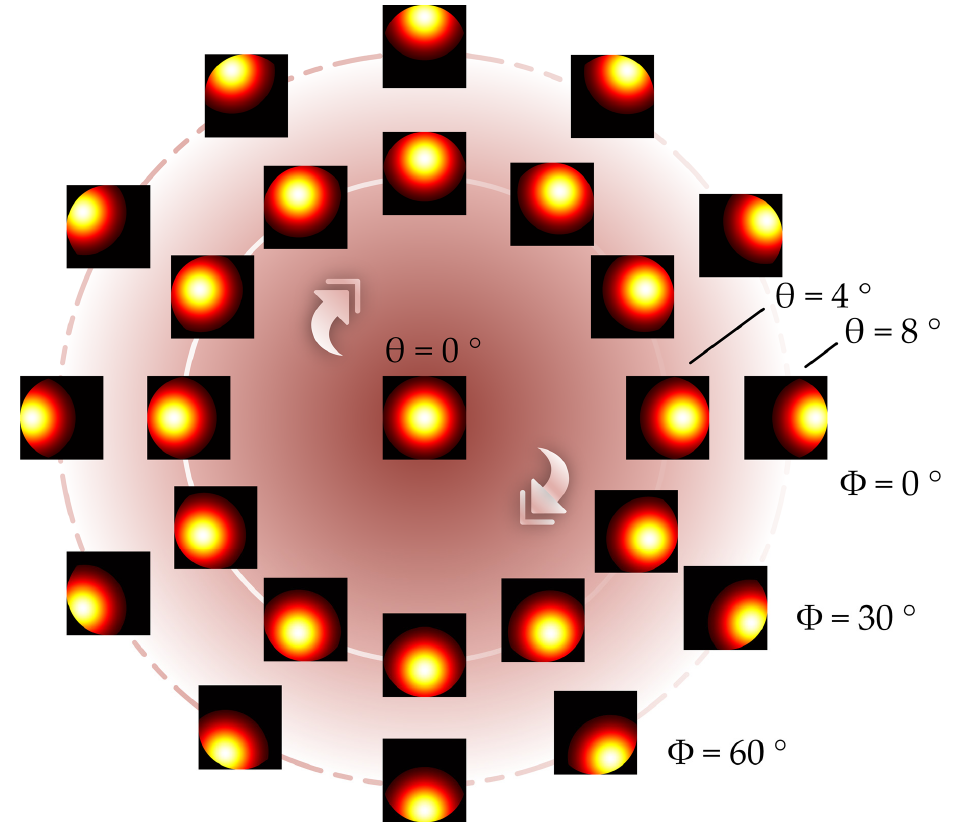
Figure 5. Changes in the peak position of light spot at different tilt angles.